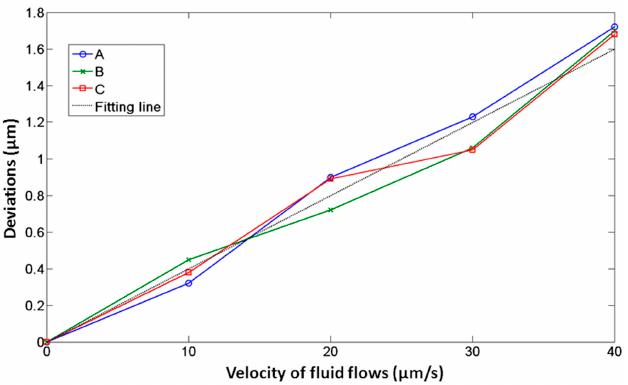
Figure 8. Deviations of optical handling spheres, namely, A, B, and C, of the microtool as functions of fluid flow velocities when the laser power of each optical trap is 0.3 W.